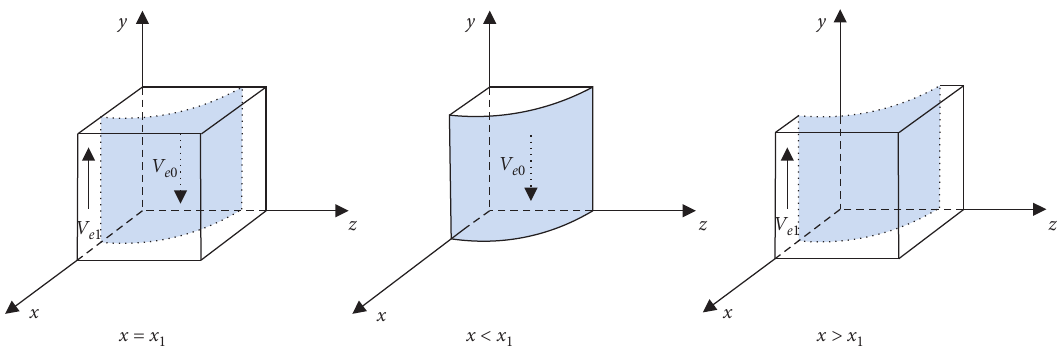
Figure 3: Phase diagram of drug enterprises strategic